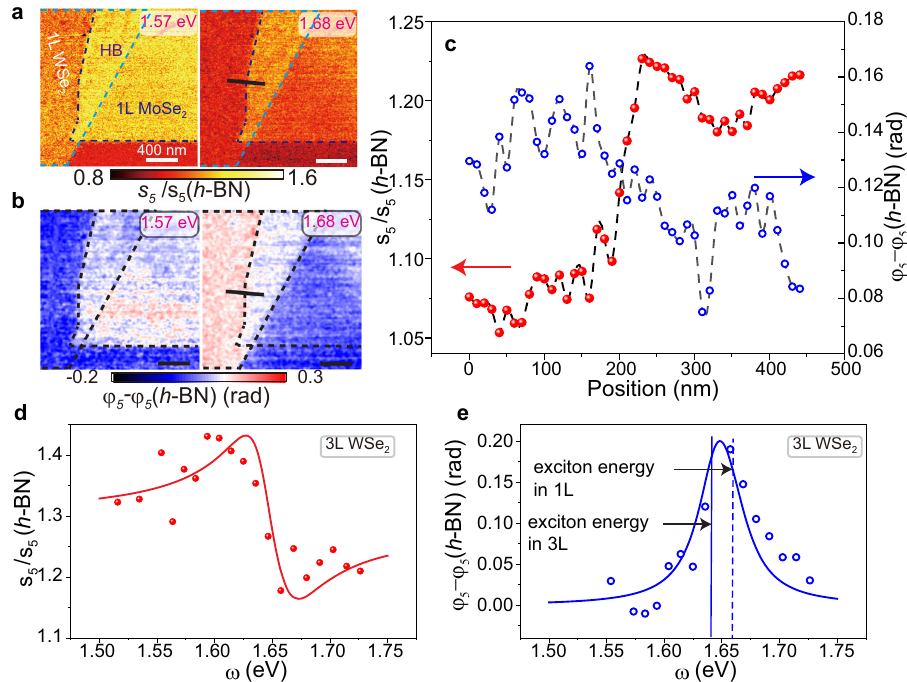
Fig. 4 Screening length of excitons in heterostructure and the effect of hybridization on the exciton resonance in WSe 2 trilayer. a , b Near- fi eld images ω ð Þ (cid:2) φ h (cid:2) BN ð Þ . The images in the left and right panels were taken at 1.68 eV (around the of the normalized amplitude s 5 ω ð Þ = s 5 ð h (cid:2) BN Þ and phase φ 5 5 monolayer WSe 2 exciton resonance energy) and 1.57 eV (around monolayer MoSe 2 exciton resonance energy), respectively. The boundaries of the materials are displayed with dash lines. The scale bars indicate 400nm. c Line pro fi les of the normalized amplitude and phase across the monolayer and ω ð Þ spectra for WSe heterobilayer along the black lines in the right panels in ( a and b ). d , e Normalized scattering amplitude s 5 ω ð Þ = s 5 ð h (cid:2) BN Þ and phase φ 2 5 trilayer (data points). The near- fi eld data are fi tted by the point dipole model (solid curves). The vertical blue dashed and solid lines in e are used to mark the exciton energies of WSe 2 monolayer and WSe 2 trilayer extracted from the point dipole model,